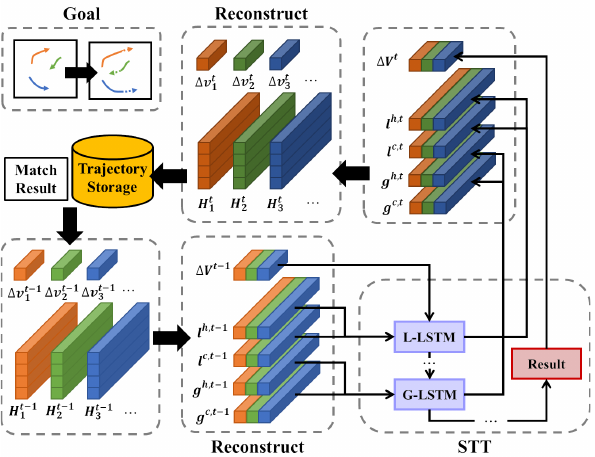
Figure 5. Process of the single time